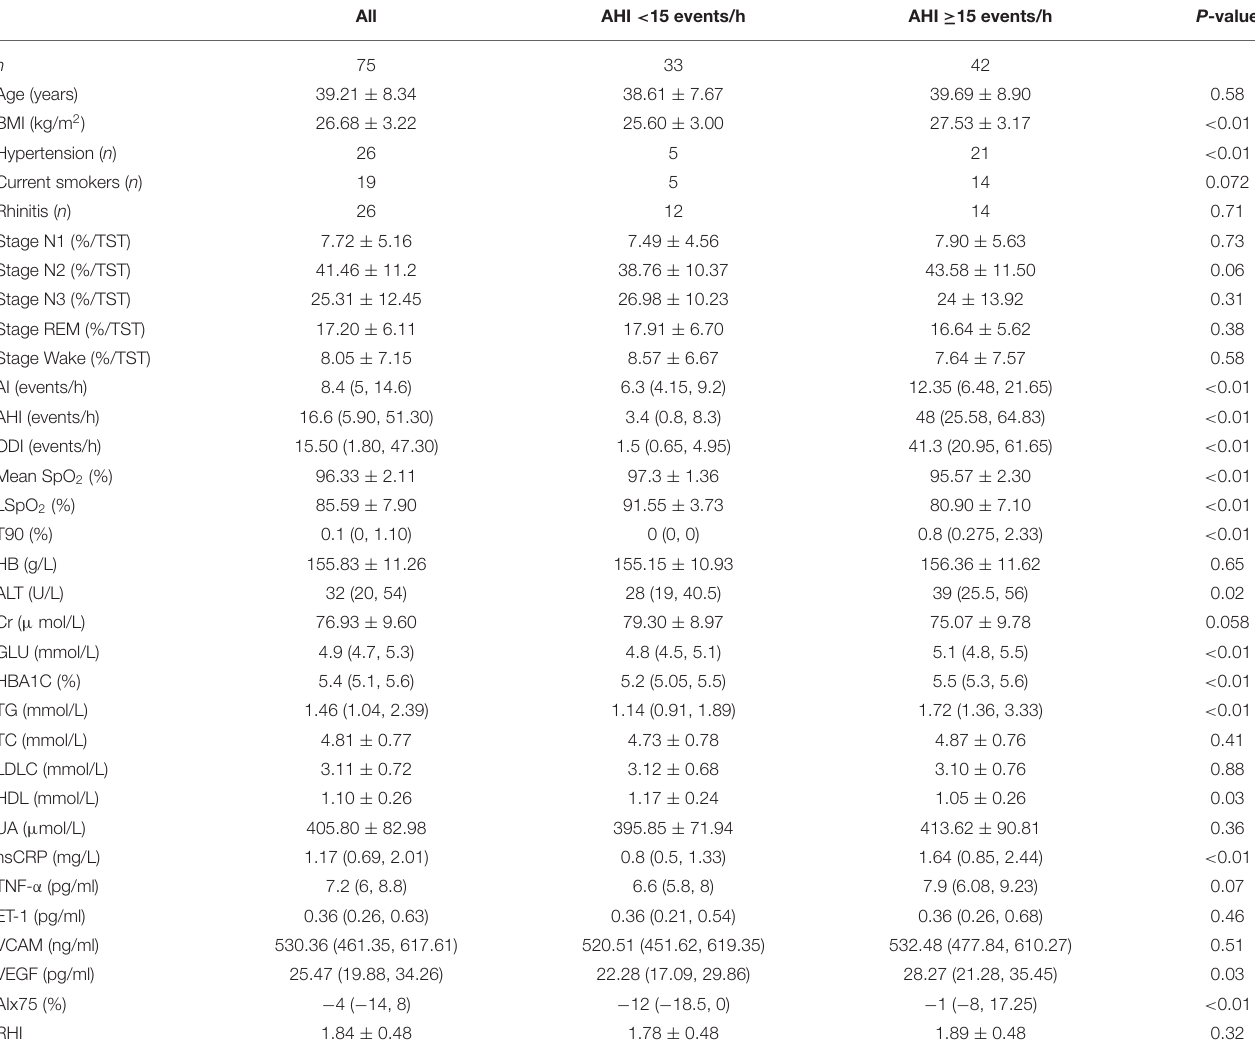
TABLE 1 | Clinical data and laboratory data of